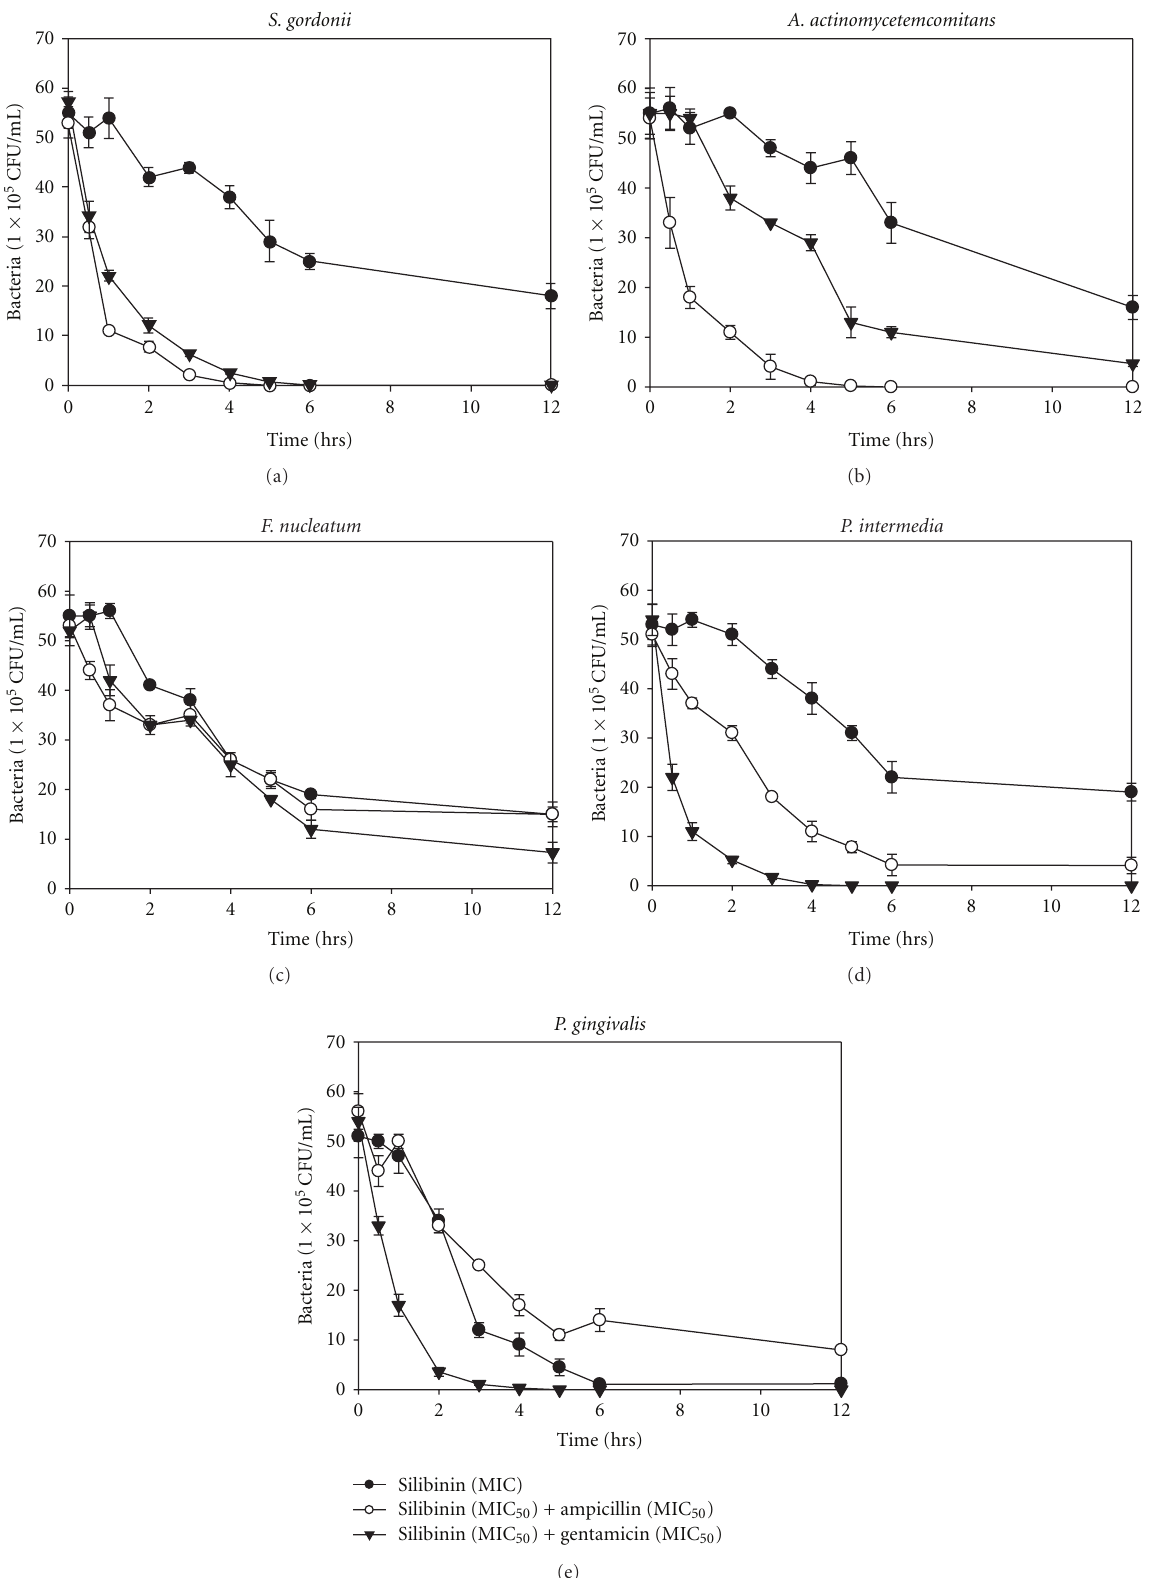
Figure 2: Time-kill curves of MIC of silibinin alone and its combination with MIC 50 of Amp or Gen against S. gordonii , A. actinomycetemcomitans , F. nucleatum , P. intermedia, and P. gingivalis . Bacteria were incubated with silibinin ( • ), silibinin + Amp ( ◦ ), and silibinin + Gen ( (cid:2) ) over time. Data points are the mean values ± S.E.M. of six experiments. CFU: colony-forming